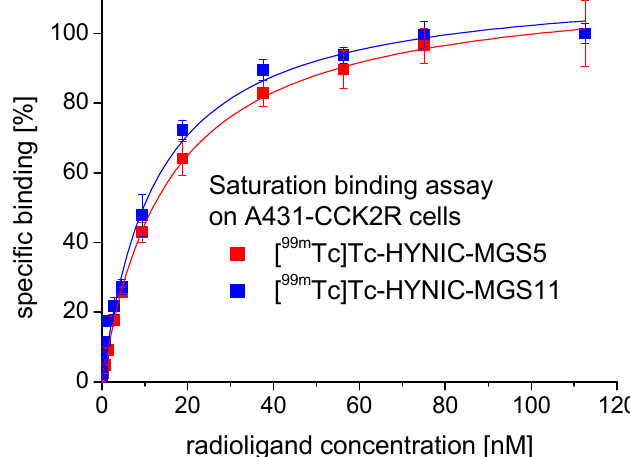
Figure 4. Representative saturation binding curve obtained on A431 ‐ CCK2R cells with [ 99m Tc]Tc ‐ HYNIC ‐ MGS5 (red) and [ 99m Tc]Tc ‐ HYNIC ‐ MGS11 (blue).